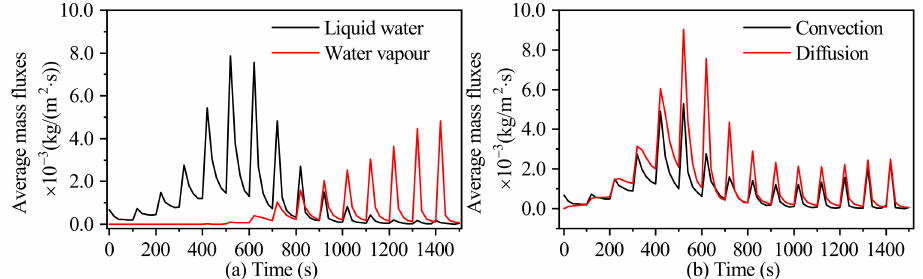
Figure 7. The average mass fluxes of different phases and different driving forces. ( a ) Average mass fluxes for liquid water and water vapor. ( b ) Average mass fluxes for diffusion and convection.